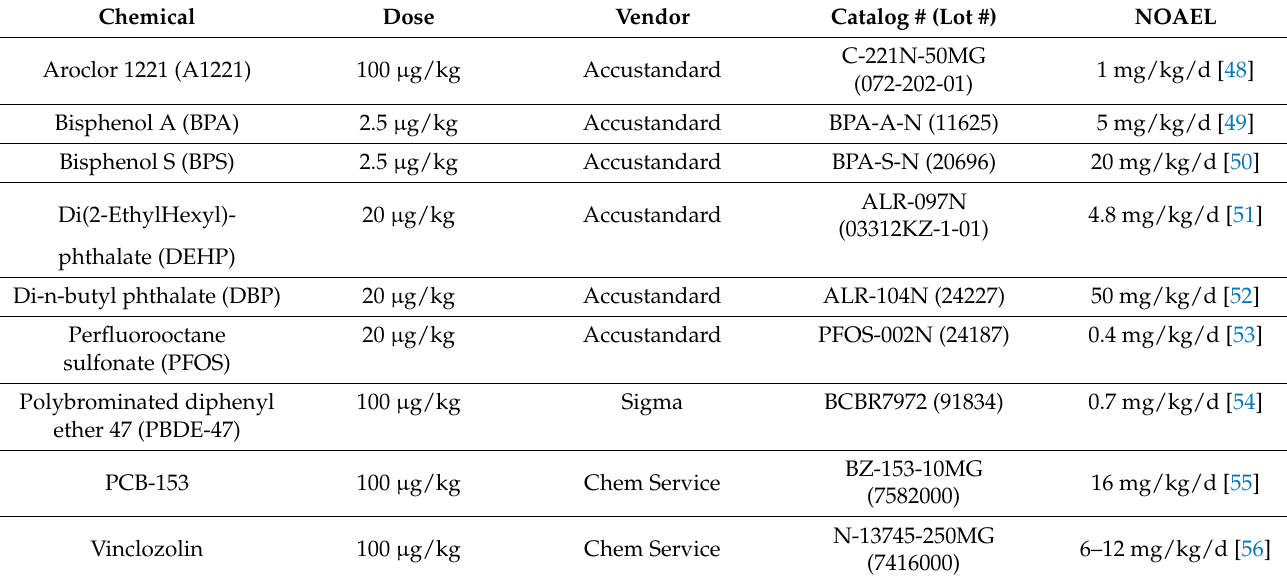
Table 1. Composition of the